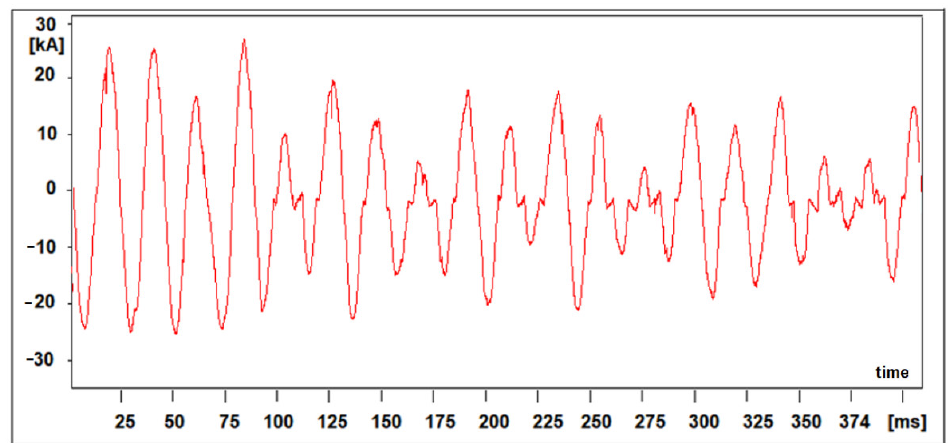
Figure 4. The oscillogram of the arc furnace current recorded in the next phase of scrap melting.